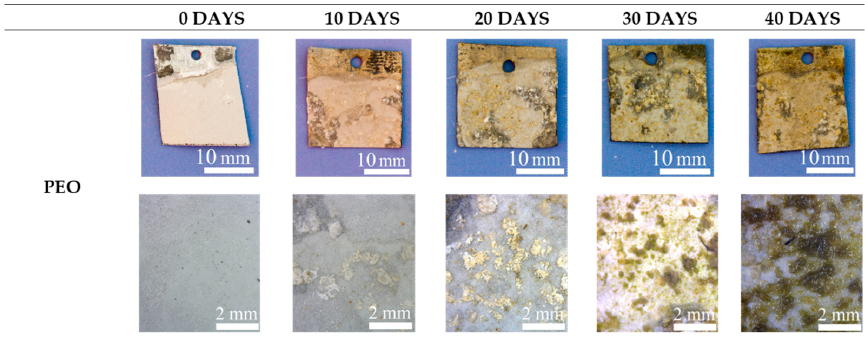
Figure 11. Visual observation (on the upper part) and stereo-microscope observation (on the bottom part) of the untreated samples after 0, 10, 20, 30 and 40 days of immersion in circulating seawater at the Hydrobiological Station Umberto D’Ancona.